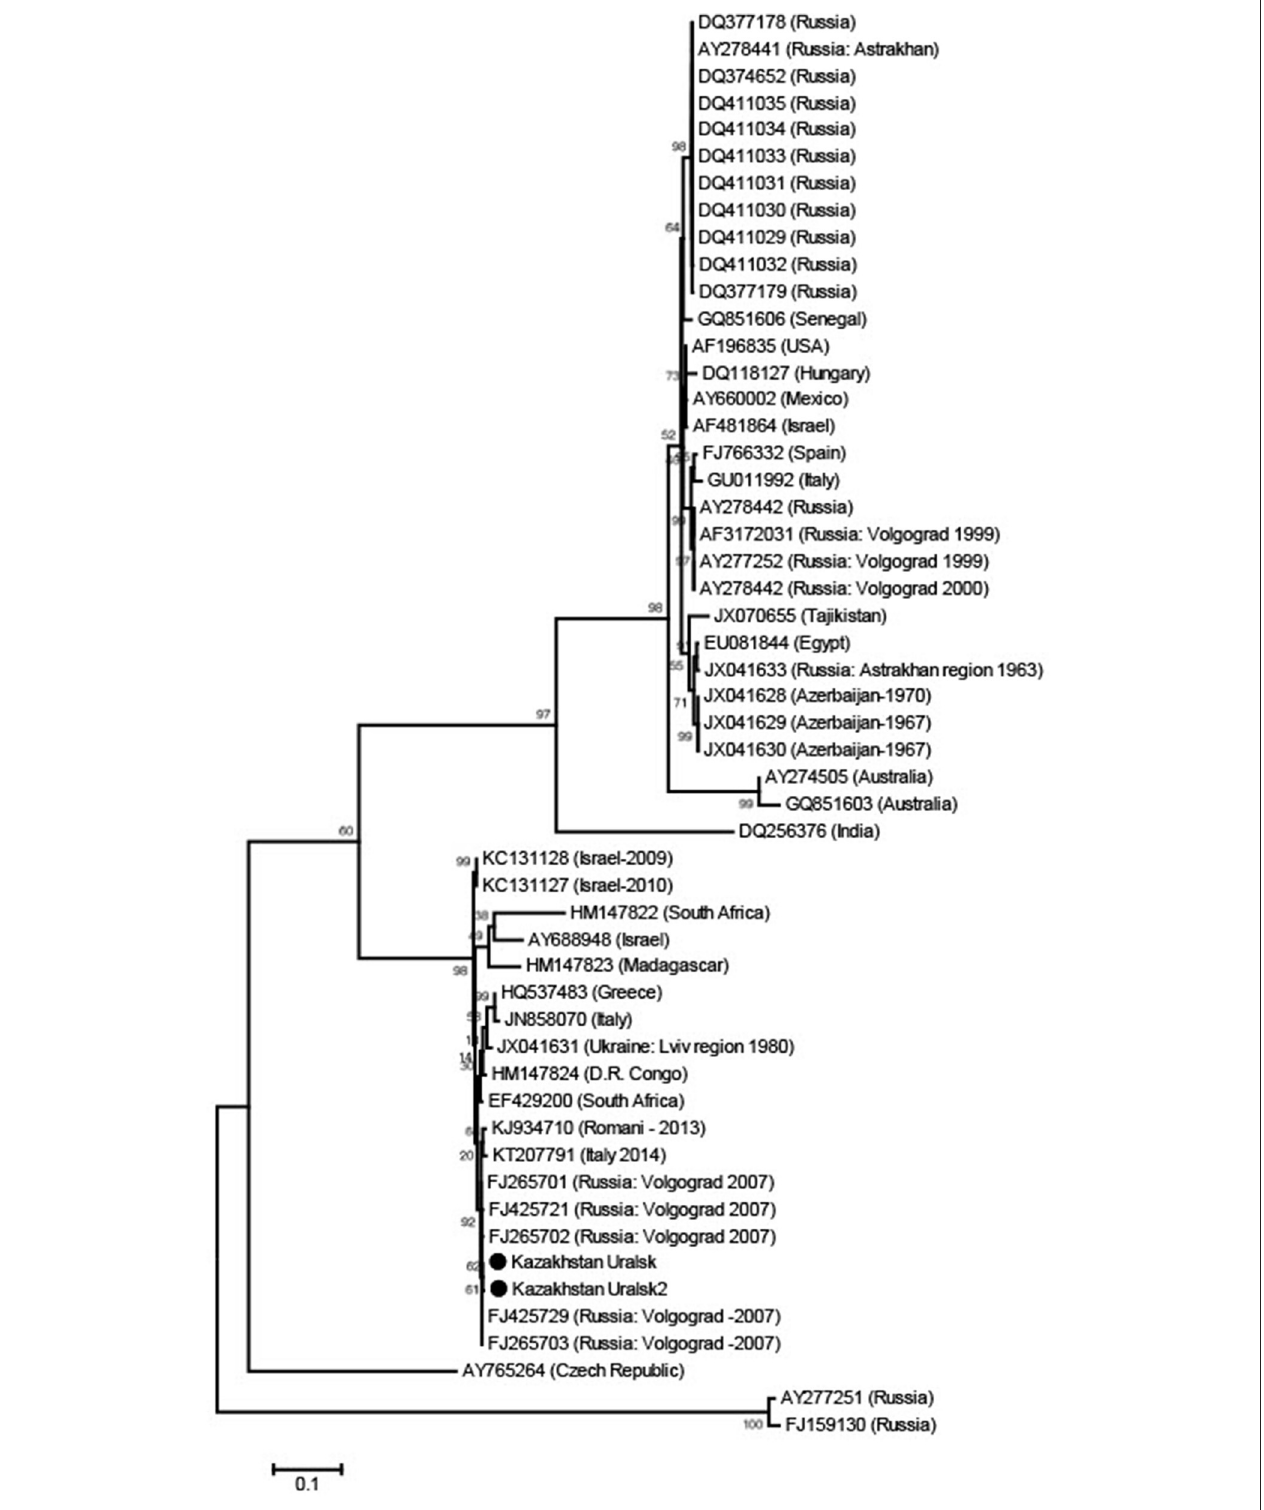
FIGURE 1 | Phylogenetic tree from WNV E gene sequences using Maximum Likelihood. The sequences were obtained from C. modestus mosquitoes collected in NW Kazakhstan.